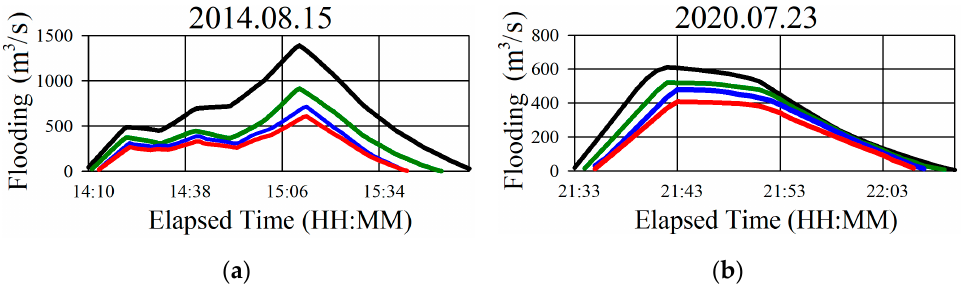
Figure 9. Flood reduction in the Suyeong River when the dam’s height is raised (actual rainfall).